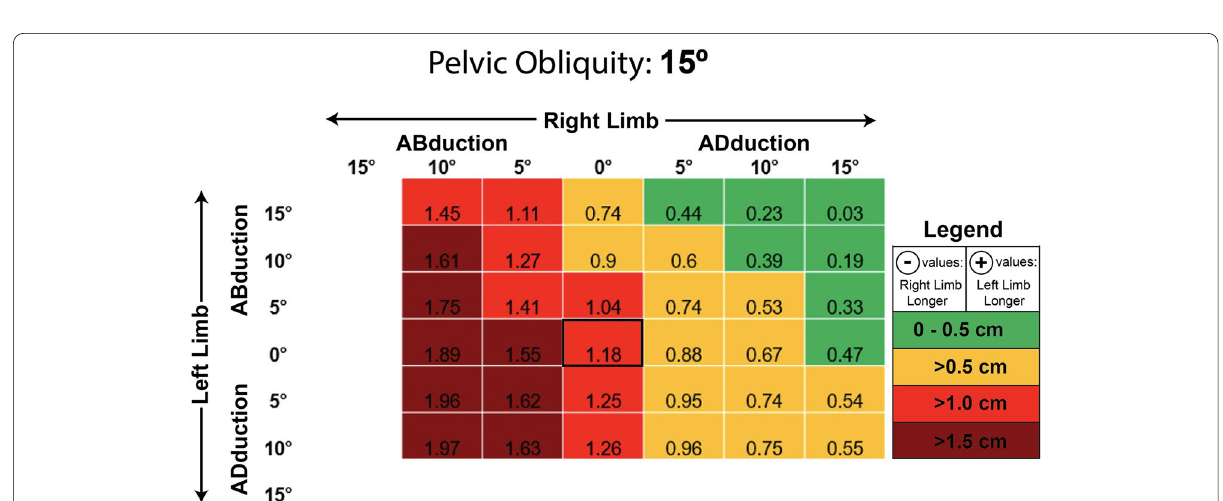
Fig. 7 Measurement error in centimeters seen at varying limb positions when the pelvic is set to 15 degrees of lateral